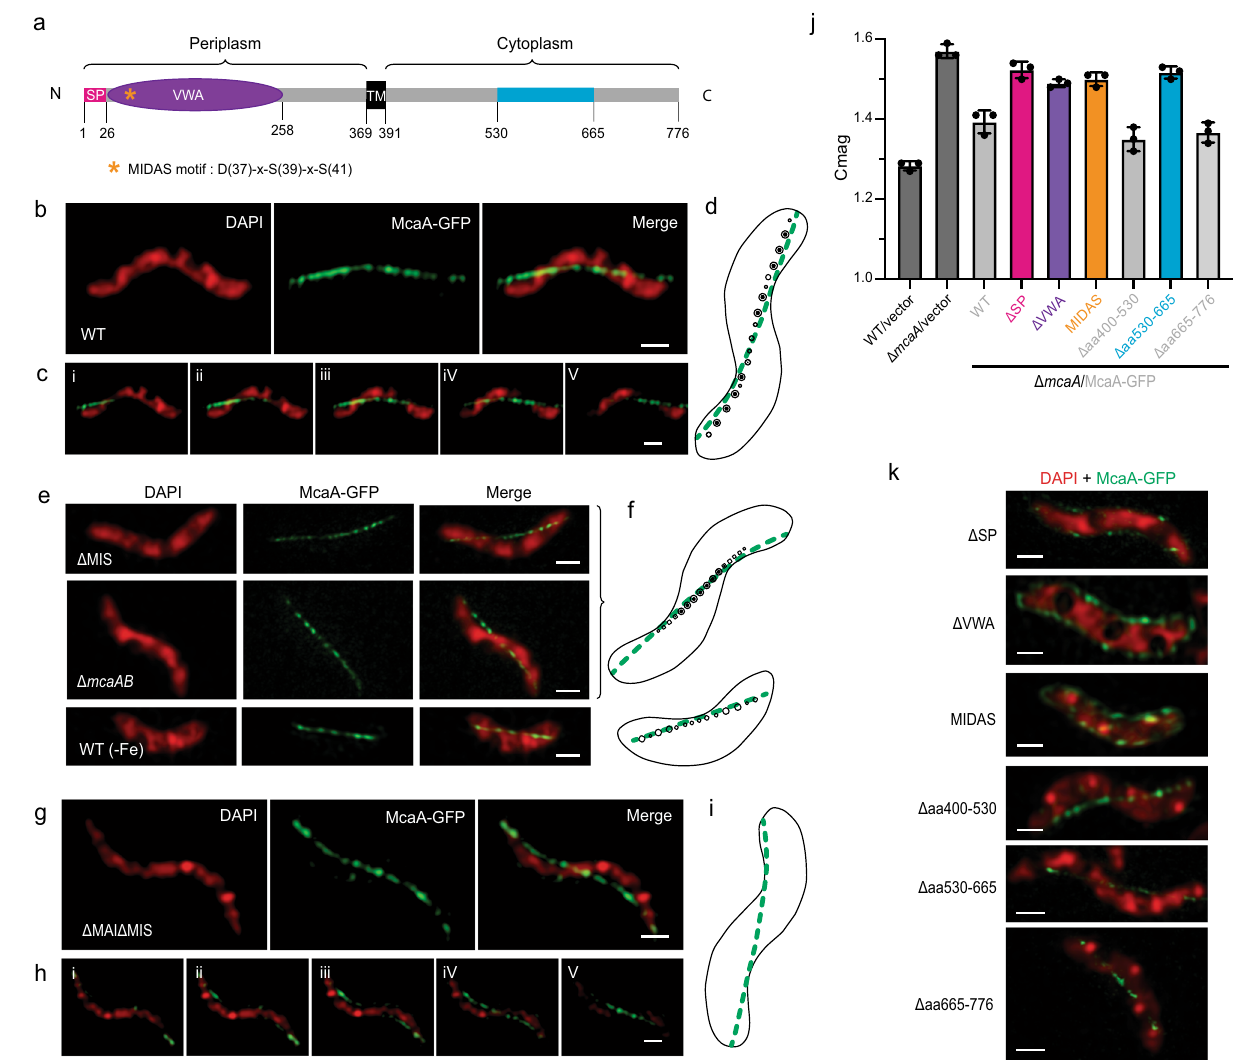
Fig. 4 | Localization of McaA. a Predicted secondary structure and topology of McaA. The whole protein is shown in a light gray line. The conserved C-terminus regionishighlightedinblue.SPsignalpeptide(magentaline),VWAvonWillebrand factor type A domain (purple oval), TM transmembrane domain (black rectangle), MIDAS metal ion-dependent adhesion site (orange star). b Representative maximum-intensity projection of 3D-SIM micrographs shows a WT AMB-1 cell expressingMcaA-GFP. c Consecutivez-sliceswithadistantspacingof100nmfrom themergedchannelof b . d AmodelofmagnetosomeproductionandMcaA(green) localization in a WT AMB-1 cell. e Representative maximum-intensity projection of 3D-SIM micrographs shows cells expressing McaA-GFP in different genetic back- grounds or growth conditions. f Models of magnetosome production and McaA